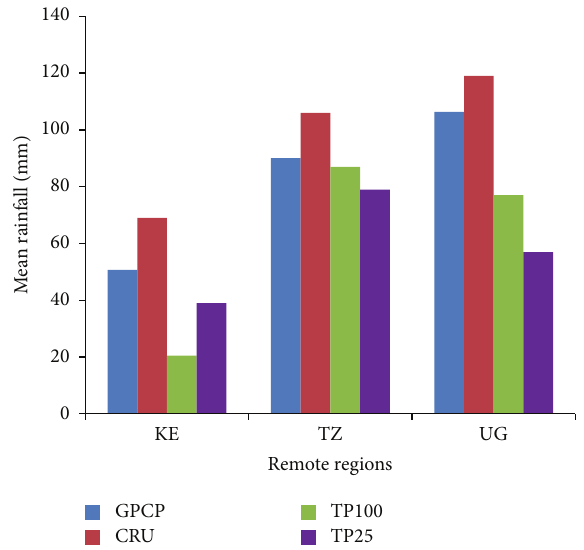
Figure 11: The mean OND rainfall (mm) over selected regions which are not part of KTU, refered to as remote regions, averaged over KE (37 ∘ E–39 ∘ E, 3 ∘ N–5 ∘ N) in Kenya, TZ (33 ∘ E–39 ∘ E, 10 ∘ S– 7 ∘ S) in Tanzania, and UG (30 ∘ E–33 ∘ E, 1 ∘ N–4 ∘ N) in Uganda. TP100 is due to the simulation with actual topography, TP25 represents simulation when the topography is reduced to 25%, CRU refers to the Climate Research Unit data, and GPCP is the Global Precipitation Climatology Project data.